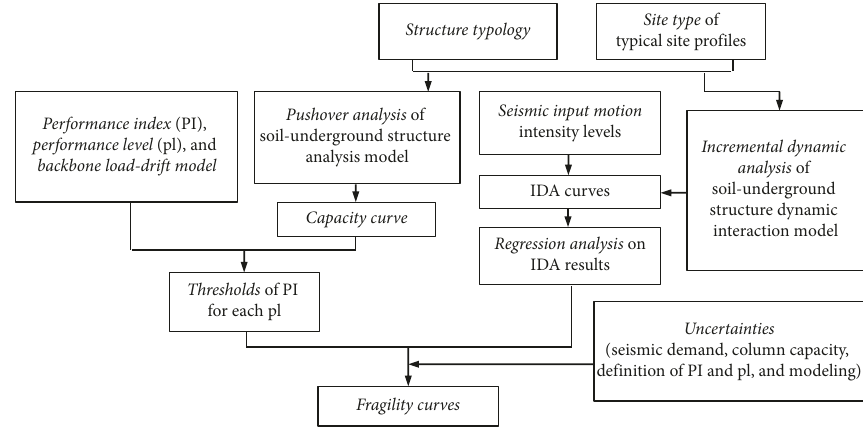
Figure 1: Proposed procedure for deriving analytical fragility curves of large-space underground